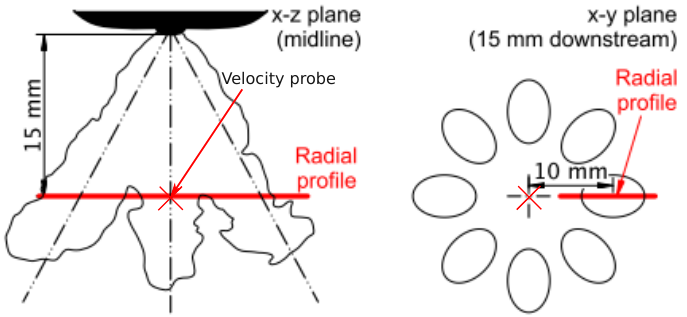
Figure 2. Location of line probe for SMD data sampling and velocity measurement point